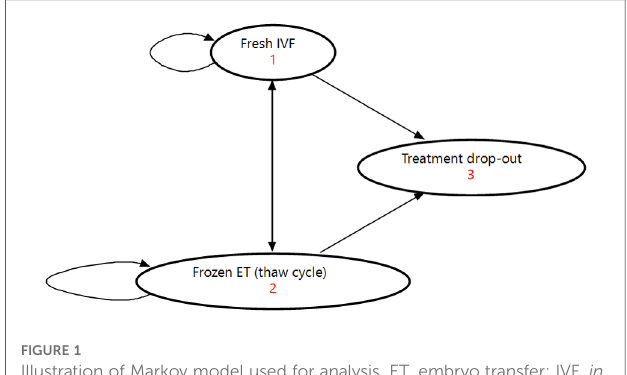
FIGURE 1 Illustration of Markov model used for analysis. ET, embryo transfer; IVF, in vitro